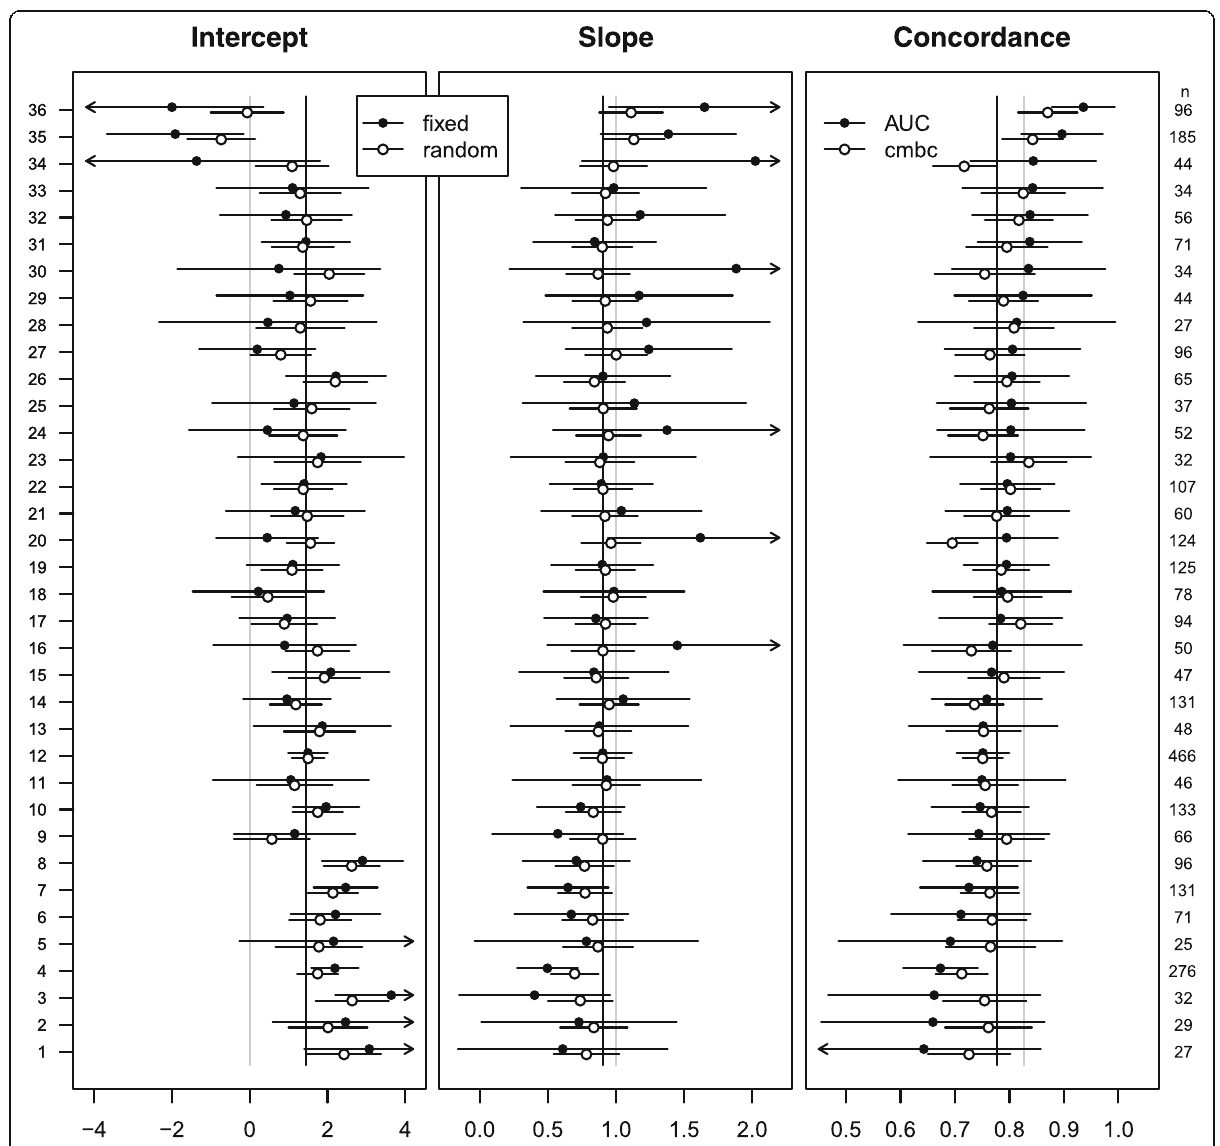
Fig. 2 Performance measures at external validation across 36 centers of the CRASH trial. Closed dots represent fixed effect intercept estimates; fixed effect slope estimates; and c-indexes in the first, second, and third panel, respectively. Open dots represent random effects intercept estimates, random effects slope estimates, and calibrated model-based concordance estimates in the first, second, and third panel, respectively. Gray vertical lines represent effect estimates of intercept (0) and slope (1) in the original regression model, together with the expected pooled concordance (0.83). Black vertical lines represent fixed effect estimates of intercept (1.44) and slope (0.90) in a multilevel regression model, together with the expected pooled concordance (0.78). The number of patients in each center is indicated on the right y